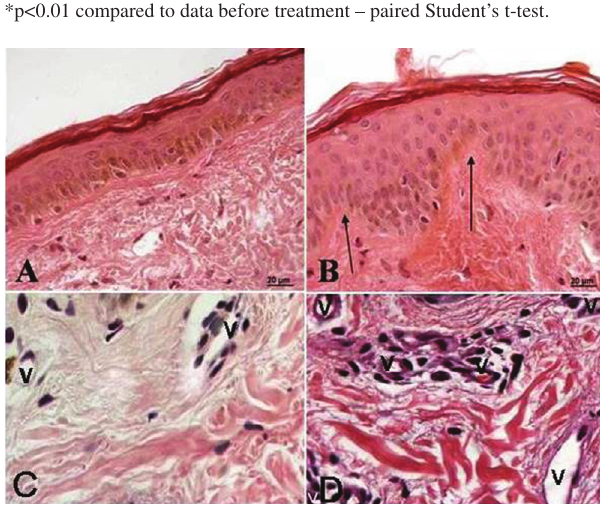
Figure 1 - Photomicrograph of a histological gluteal skin section from a patient before (A, C) and after (B, D) treatment with isoflavones. A - Note the absence of the dermal papilae and a thin epidermal layer. B - Note the increased epidermal thickness. C and D - Note the blood vessels. The ar- rows indicate the dermal papillae, and “v” are the vessels. (A and B 250x; C and D 450x,